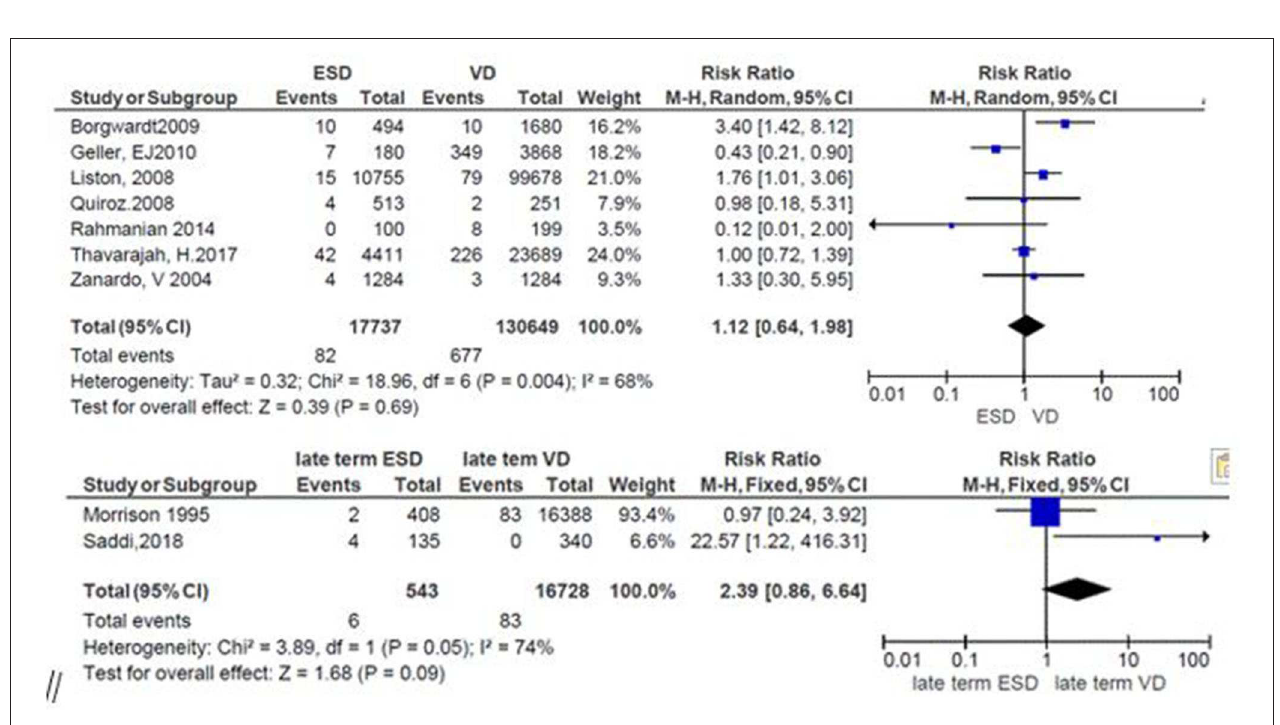
FIGURE 6 | Risk of neonatal respiratory morbidity at late term and mode of delivery, 2019.